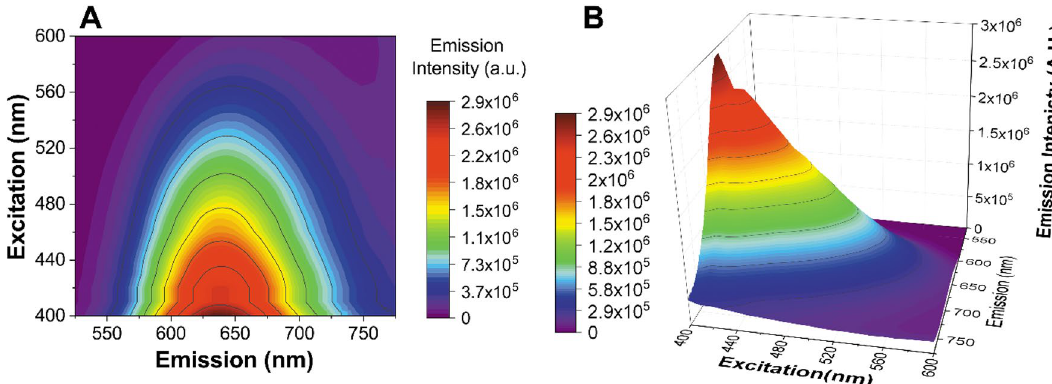
Figure 6. EEM (excitation emission matrix) of